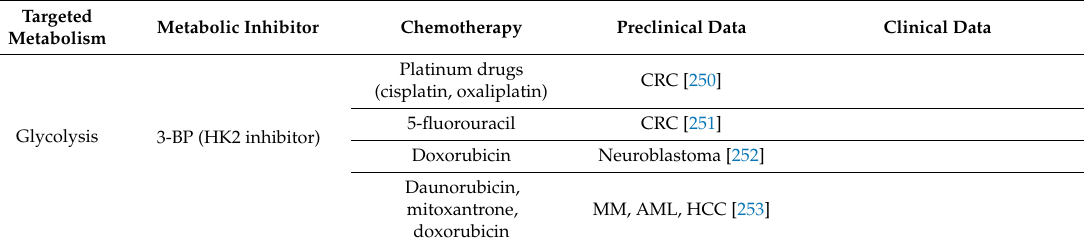
Table 3. Metabolic inhibitors in combination with